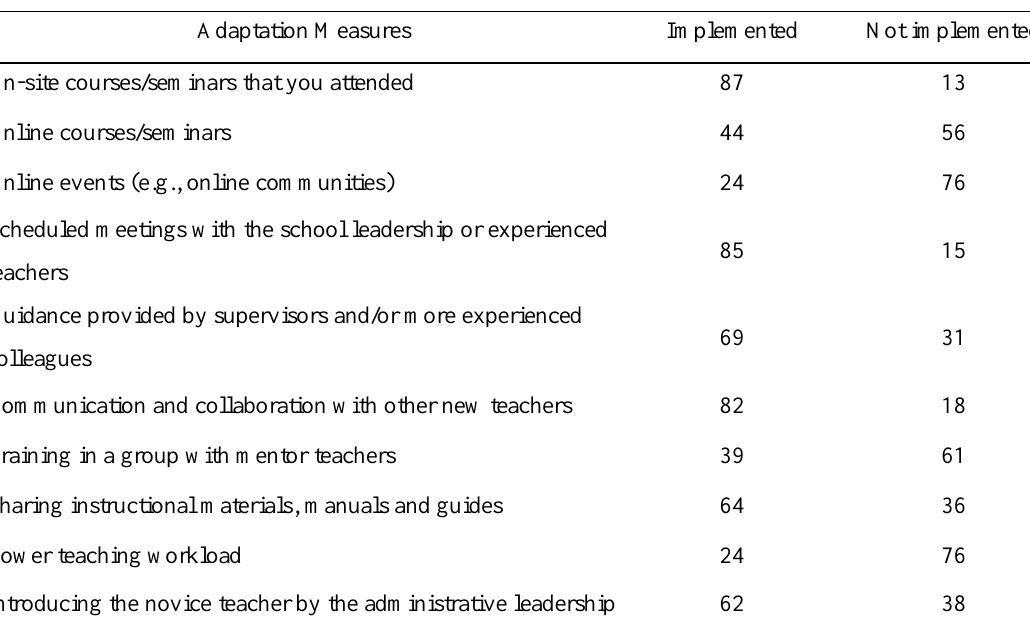
Table 2. Professional adaptation measures for novice science teachers,